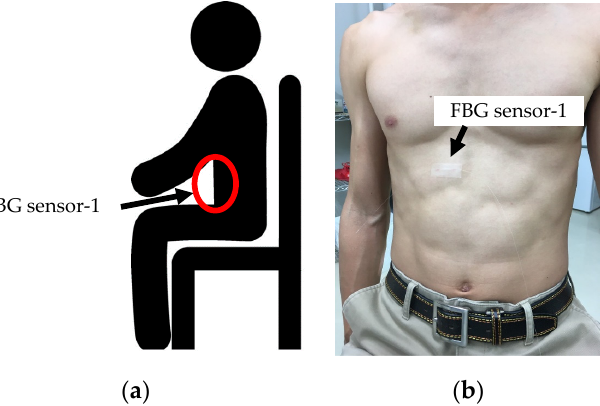
Figure 4. Subject’s posture and FBG sensor-installation position in measurement experiment of respiratory strain using FBG sensor ( a ): Subject’s posture, ( b ): FBG sensor installation position.